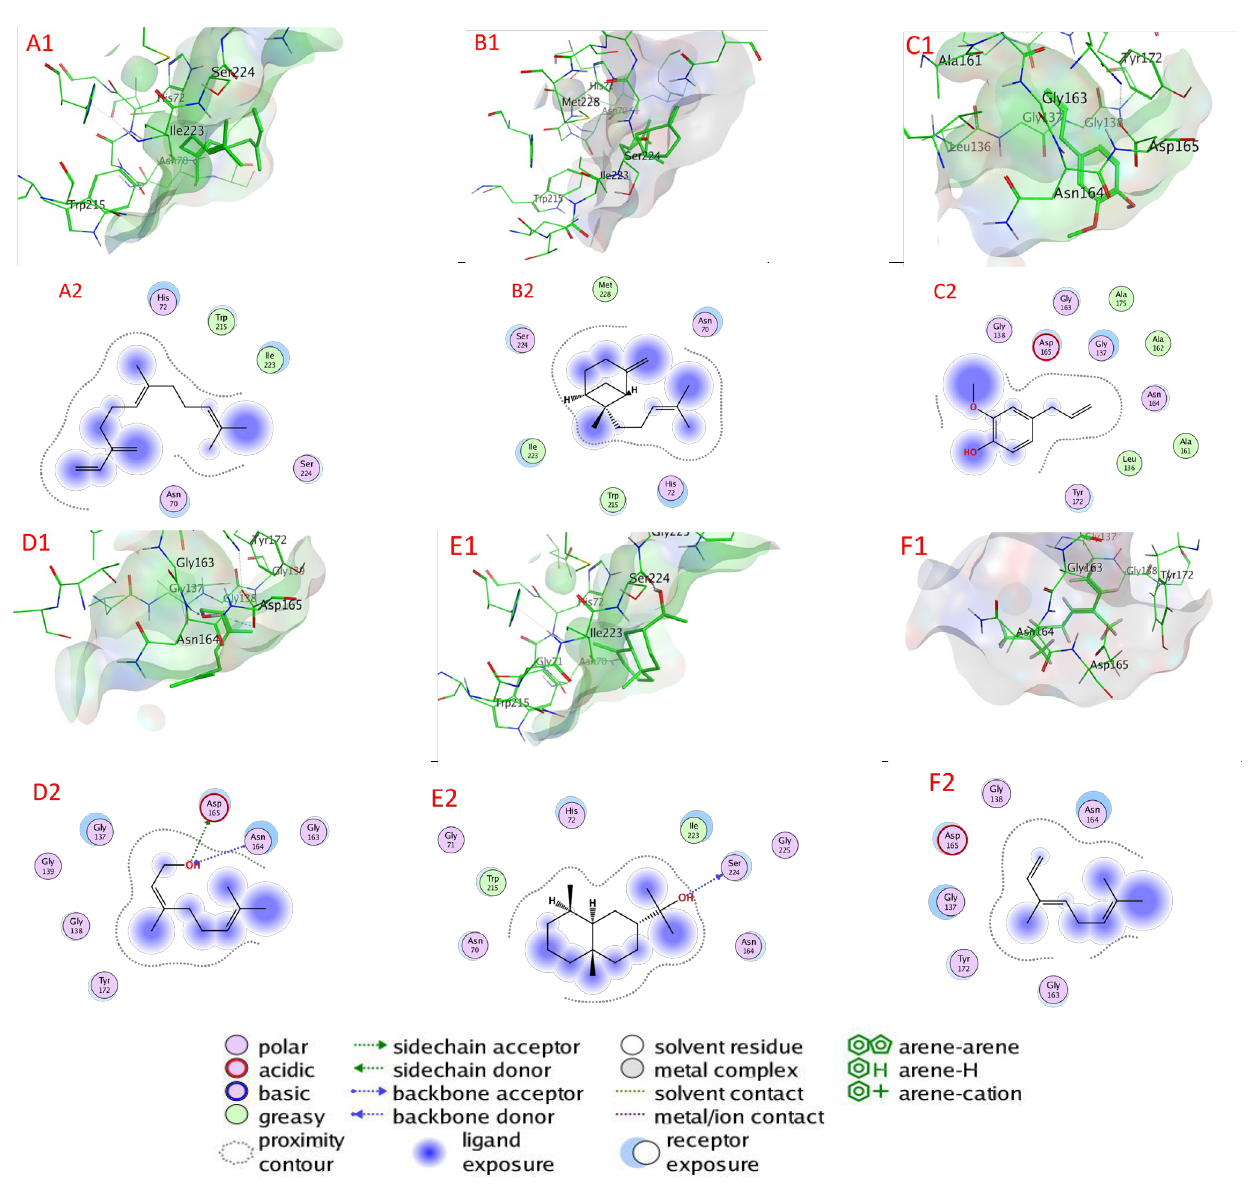
Figure 6. Docking view; ( A1 , A2 ) β -farnesene, ( B1 , B2 ) β -bergamotene, ( C1 , C2 ) eugenol, ( D1 , D2 ) nerol, ( E1 , E2 ) α -eudesmol, and ( F1 , F2 ) (E)- β -ocimene in the binding sites of serine proteinase (PDB:3F7O). ( A1 , B1 , C1 , D1 , E1 , F1 ) 3D complex structures (stereoview) and ( A2 , B2 , C2 , D2 , E2 , F2 ) 2D interaction diagram structures.